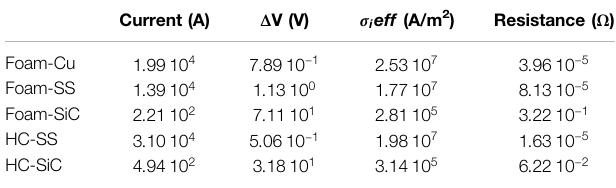
TABLE3| Electricalparametersofdifferentstructuredreactorstoprovideapower density of 10 MW/m 3